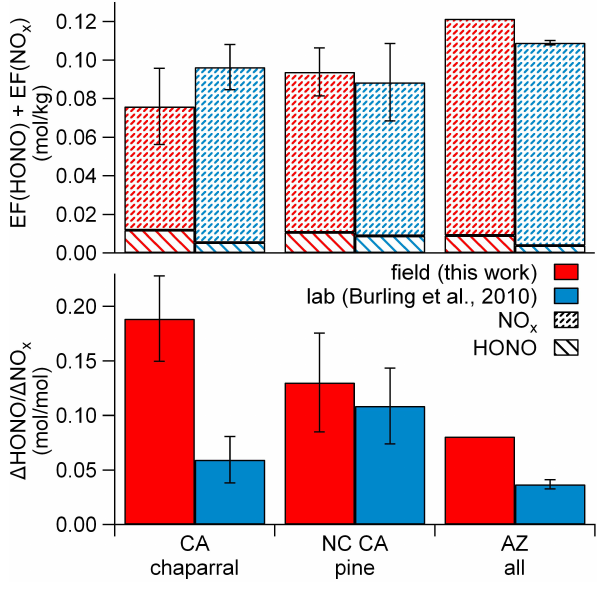
Fig. 6. Lower panel: comparison of the average molar 1 HONO/ 1 NO x ratios for the various fuel types studied in this work (airborne) and the laboratory study of Burling et al. (2010). Upper panel: average sum of the molar emission factors of HONO and NO x (in mol kg − 1